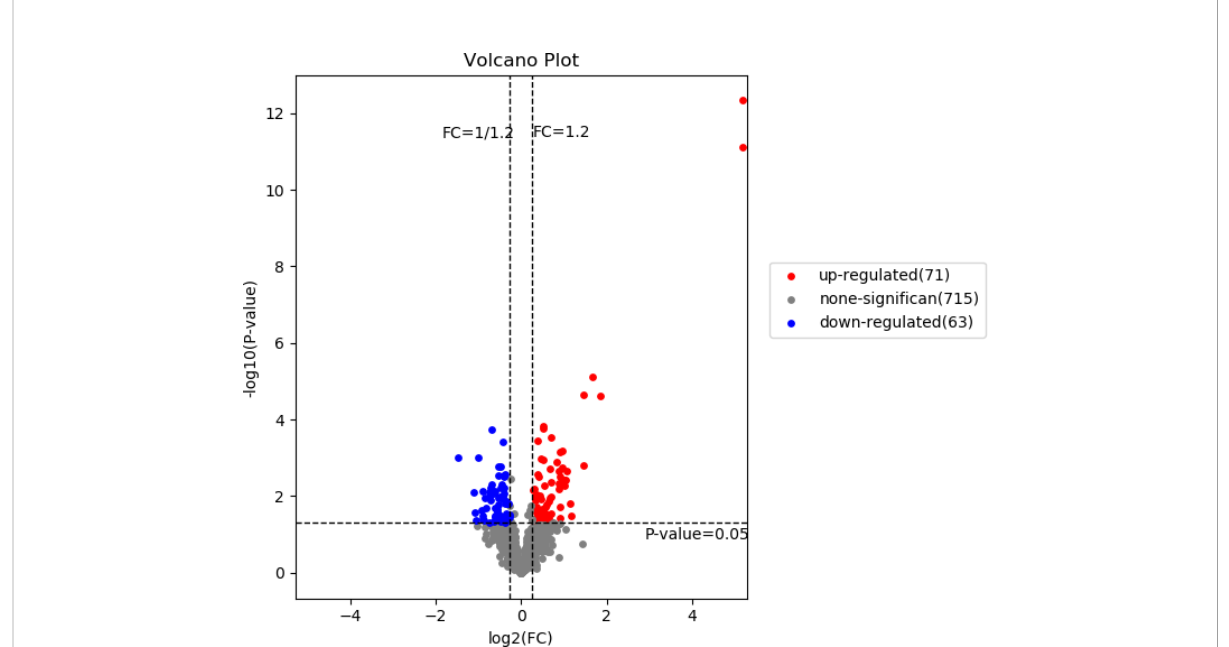
FIGURE 1 A volcano plot of the differentially expressed proteins. The red and blue dots represent signi fi cantly up-regulated and down-regulated DEPs, respectively. The horizontal dotted line represents p value <0.05, two vertical dashed lines indicate Fold change=1.2 and Fold